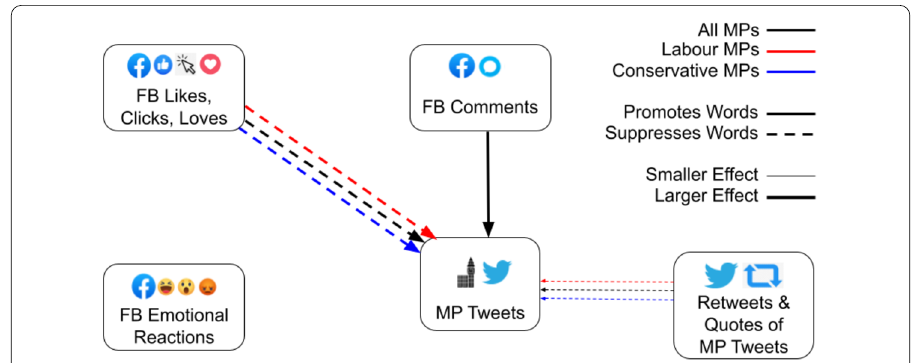
Figure 8 Marginal change in word transfer to MP Tweets associated with different kinds of interactions. Lines indicate statistically significant measurements. Colors indicate the party of the MPs for whom we’re measuring a response. Solid lines indicate a positive magnitude; dotted lines indicate a negative magnitude. Line thickness is proportional to the log of the measured effect. See Table 2 for precise magnitudes, p -values, an 95% confidence